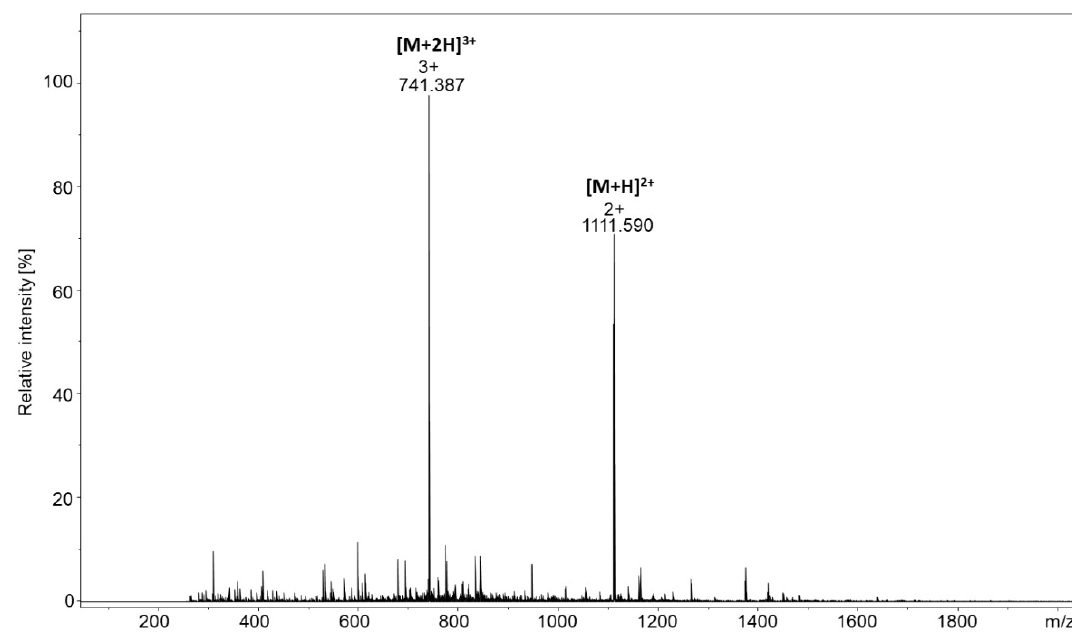
Figure 4. ESI-MS spectrum of the derivatized peptide conjugate obtained from a single resin bead. Molecules 2020 , 25 , x FOR PEER REVIEW Additionally, to show the selectivity of the proposed method toward the cysteine-containing peptides, the model peptide and its oxidized analogue containing disulfide bridge were incubated with the linker-containing TentaGel resin and derivatized with the fixed charge tag. The obtained results clearly demonstrate that only the cysteine-containing peptide was captured and derivatized, whereas any signals corresponding to other products were not observed (Supplementary Materials, Figure S1).